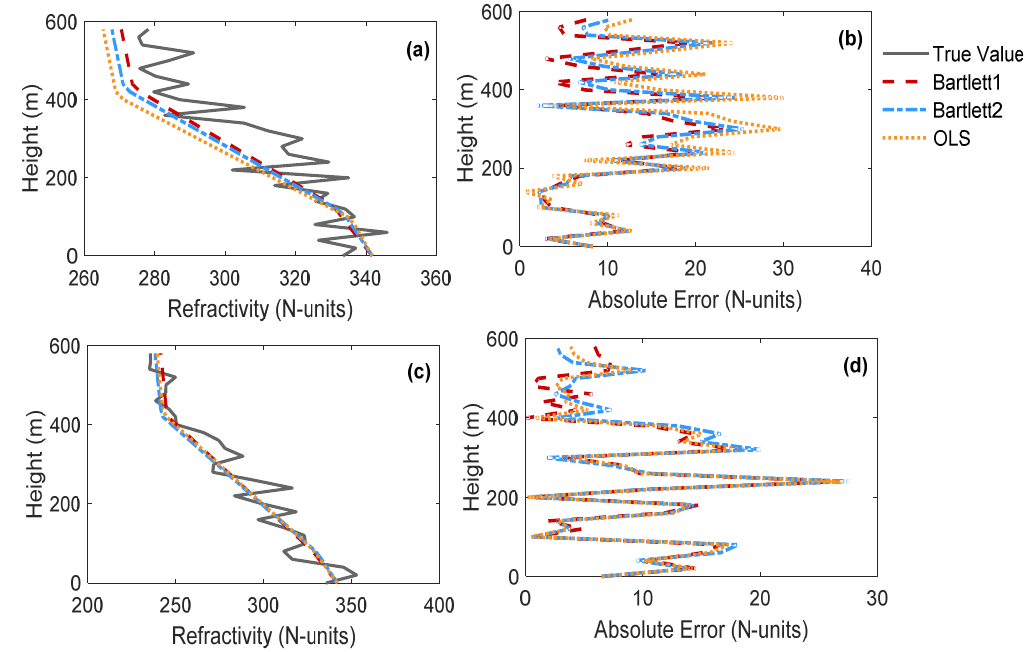
Figure 11. Refractivity profiles by different inversion methods for real atmospheric environment.